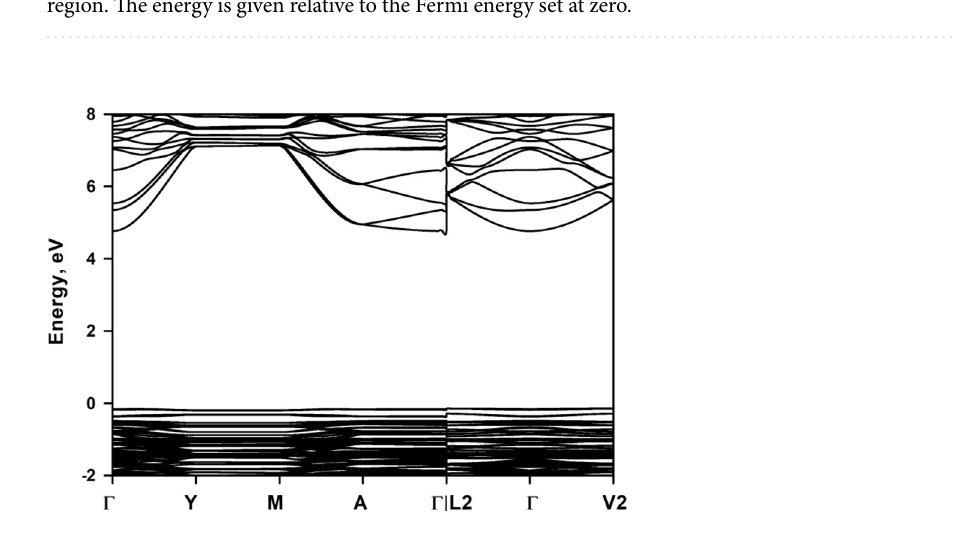
Figure 4. Band structure of bulk mica along high symmetry